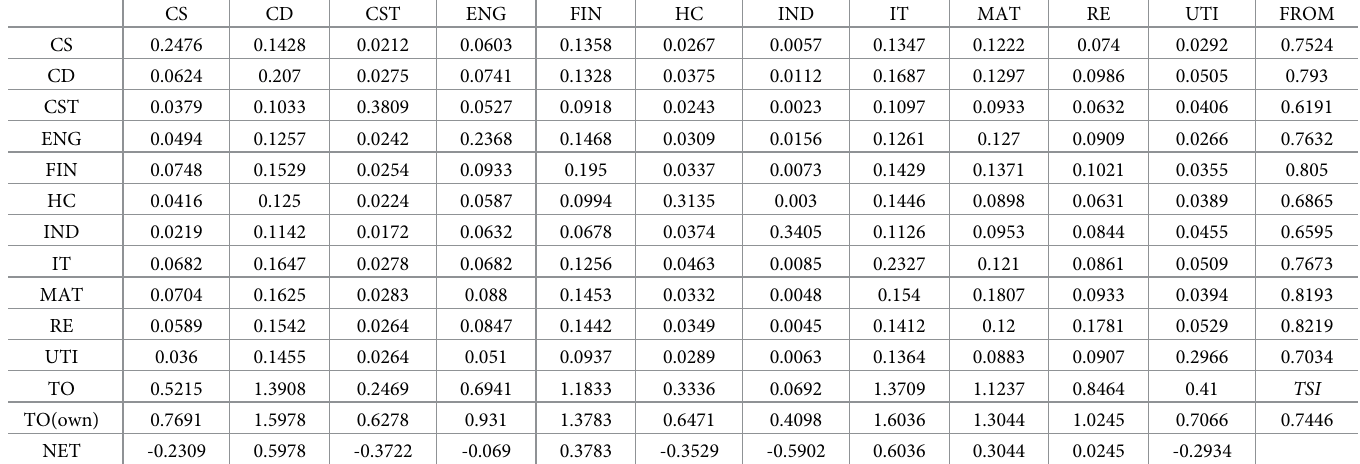
Table 4. Summary of liquidity spillovers in all the sectors during the COVID-19 pandemic period (from January 2020 to March 2022). The optimal lag order accord- ing to the AIC is